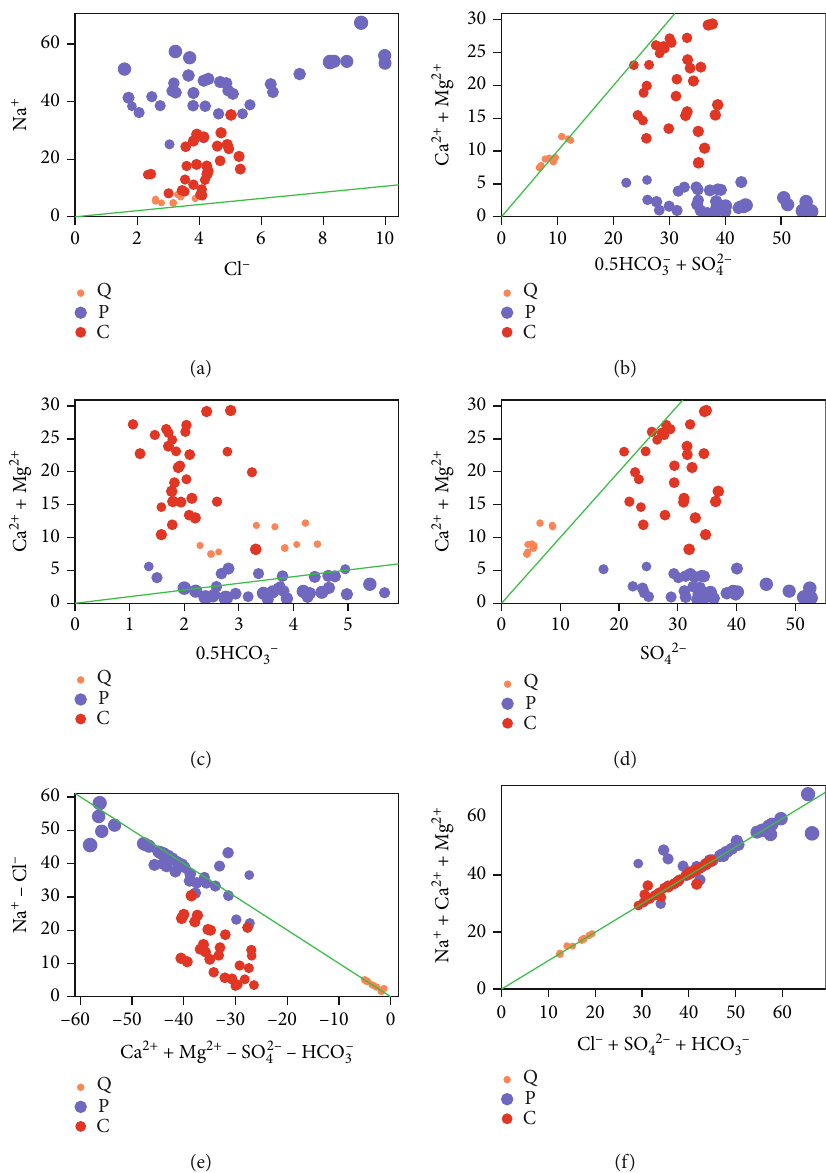
Figure 4: Bubble chart of ion combination of di ff erent